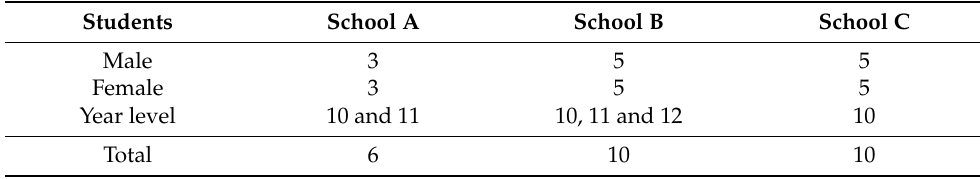
Table 2. Numbers of participating high school